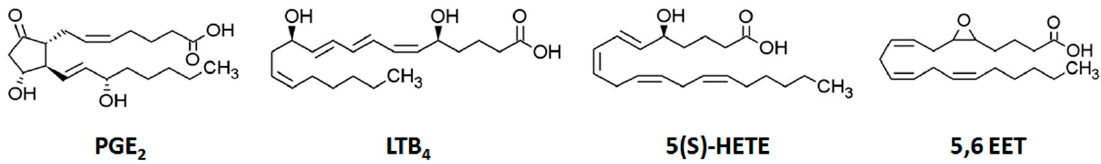
Figure 1. Chemical structures of typical eicosanoids: prostaglandin E 2 (PGE 2 ), leukotriene B 4 (LTB 4 ), 5-hydroxy-eicosatetraenoic acid (5(S)-HETE), and 5,6-epoxy-eicosatrienoic acid (5,6 EET).